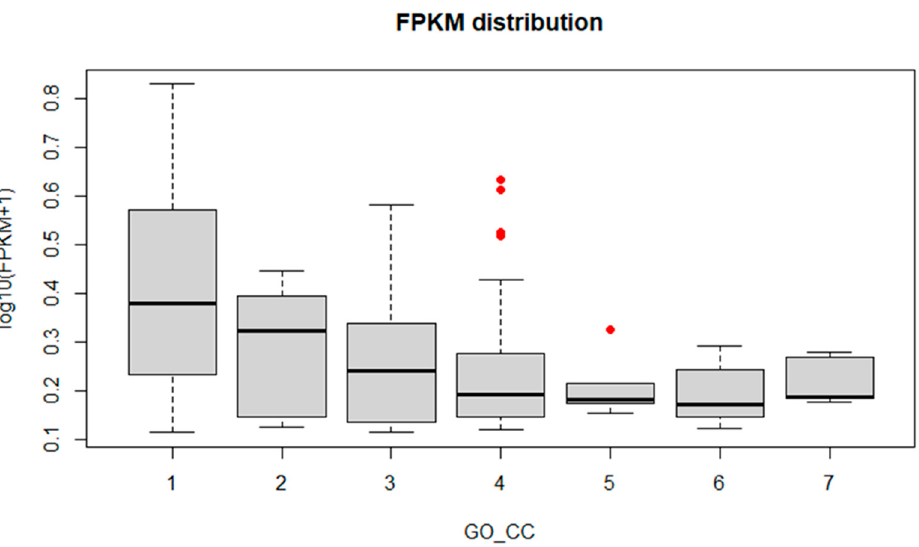
Figure 4. FPKM distribution of the most enriched GO terms (Cellular Component). The x -axis corresponds to the enriched terms with more than five Unigenes, the y-axis is the FPKM value expressed as log 10 (FPKM+1) (FPKM > 0.3). Red dots represent the ”outlier” clusters. 1: ribonucleoprotein complex; 2: cell part; 3: membrane part; 4: membrane; 5: proteasome core complex; 6: cytoplasm; 7: cell.